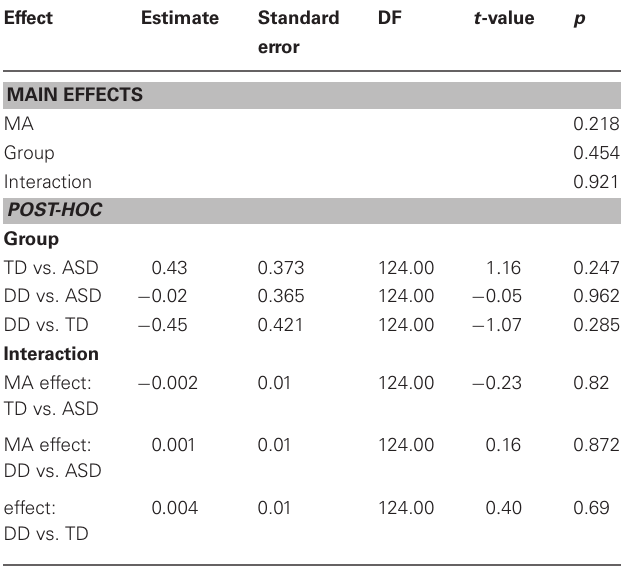
Table 10 | Peak grip force and mental age